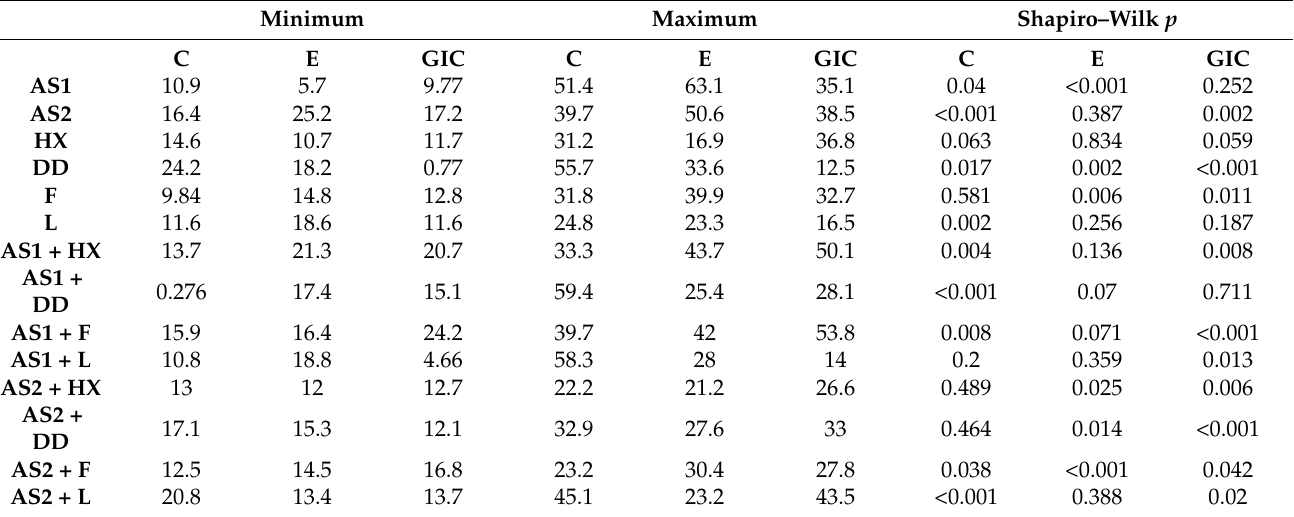
Table 3. Contact angles, pH, and conductivity of the tested solution at room temperature.